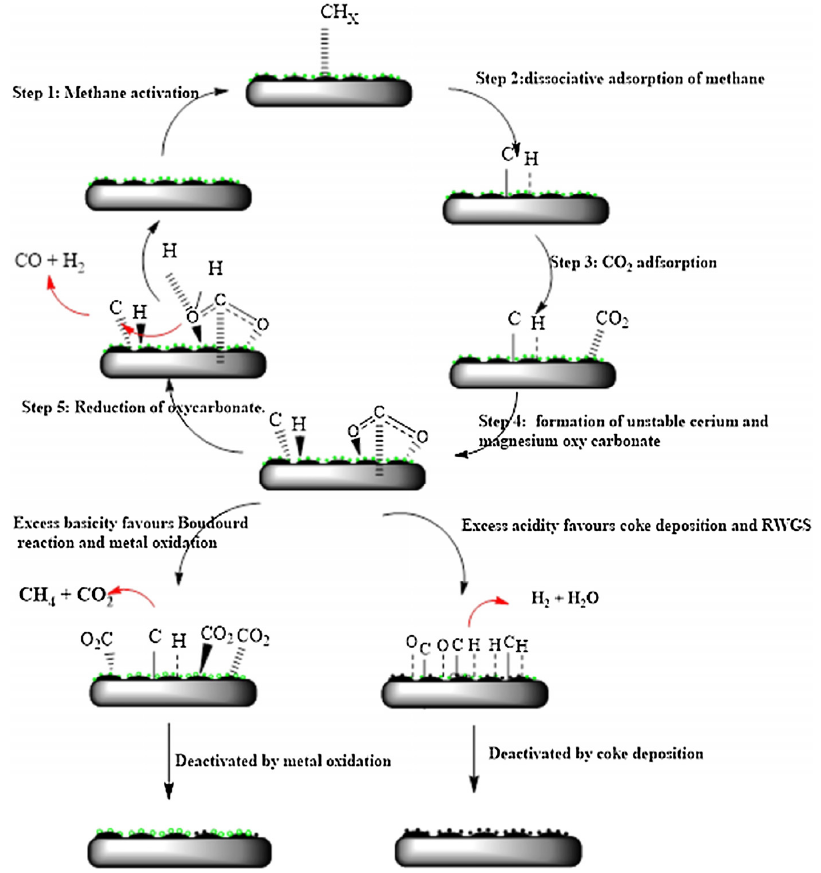
Figure 4. Suggested mechanism of deactivation of Ni catalysts supported by metal-oxides with excessive acidity or basicity. Reprinted with permission from Ref. [59]. Copyright (2017) Elsevier.